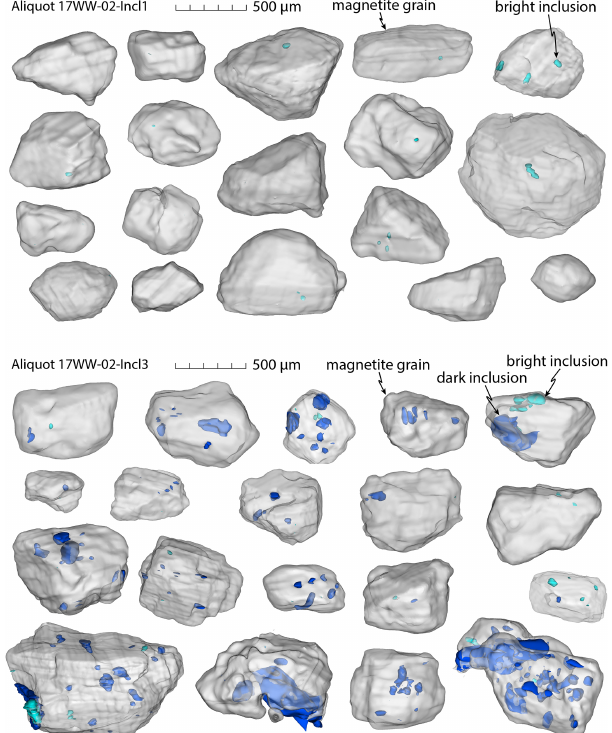
Figure 7. Segmented volume renderings of magnetite grains with bright (turquoise) and dark inclusions (dark blue) constructed from microCT data. These are all of the grains from aliquots 17WW-02- Incl1 (only bright inclusions) and 17WW-02-Incl3 (bright and dark inclusion); for helium data see Table